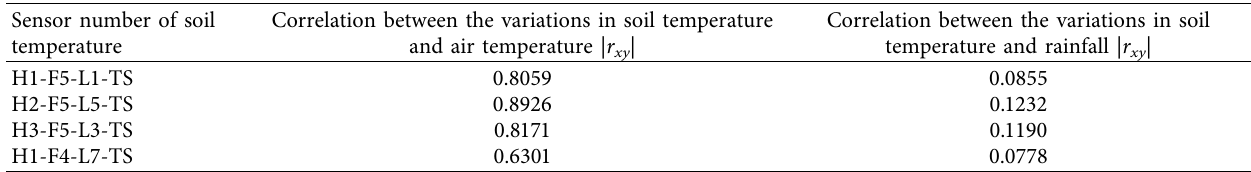
Table 3: Correlation between the variations in the soil temperature and air temperature and